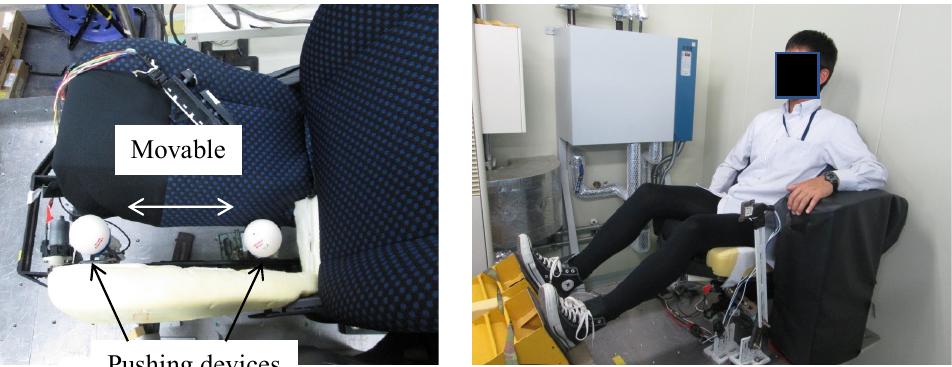
Figure 2. Sensitivity measurement seat.